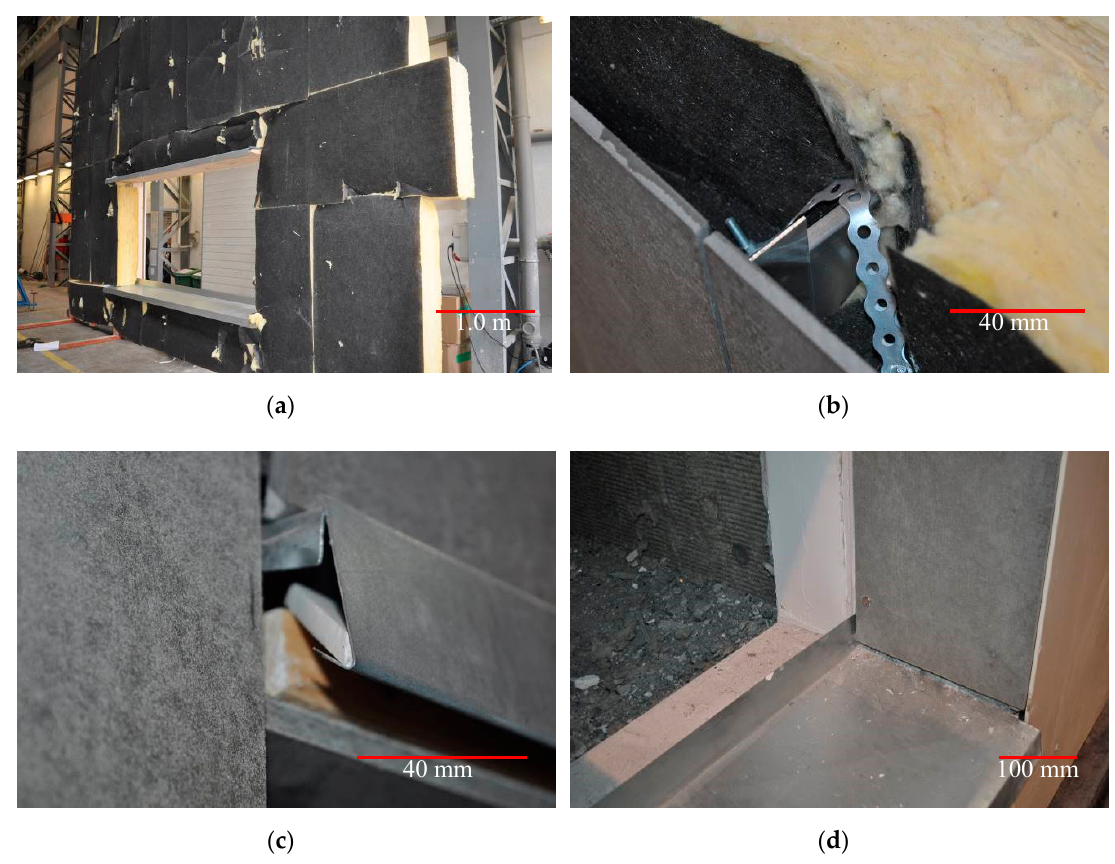
Figure 2. Selected details of the ventilated facade model under test: ( a ) thermal insulation system; ( b ) the detail of perforated tape connection with the console; ( c ) the detail of closing sheet above the window opening; ( d ) the detail of sill system.